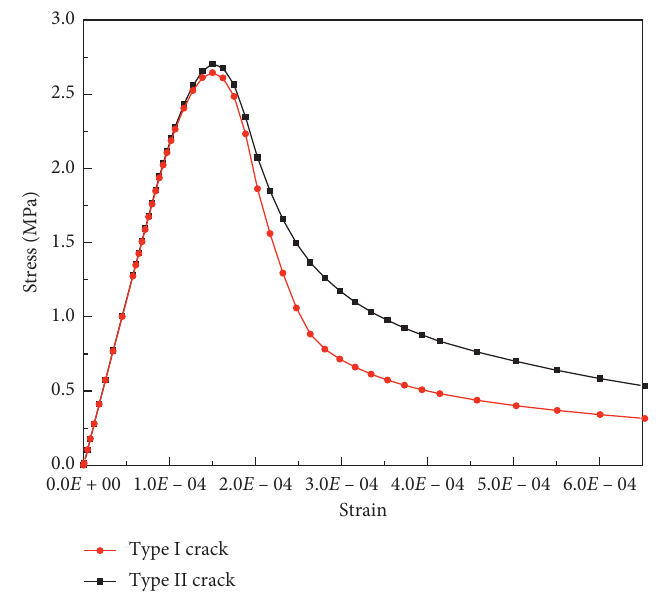
Figure 17: Stress-strain curves of the type I crack and type II crack.